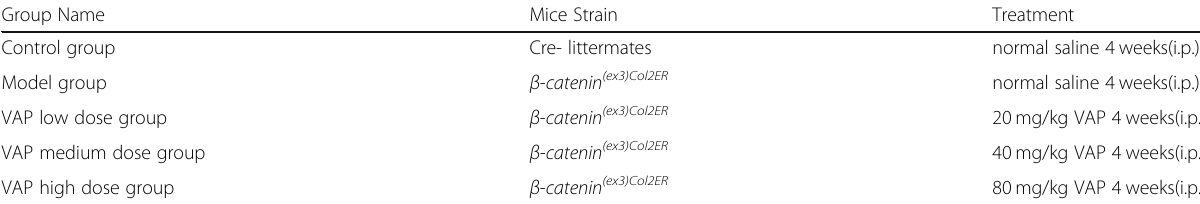
Table 1 Mice group name, strain and treatment Group Name